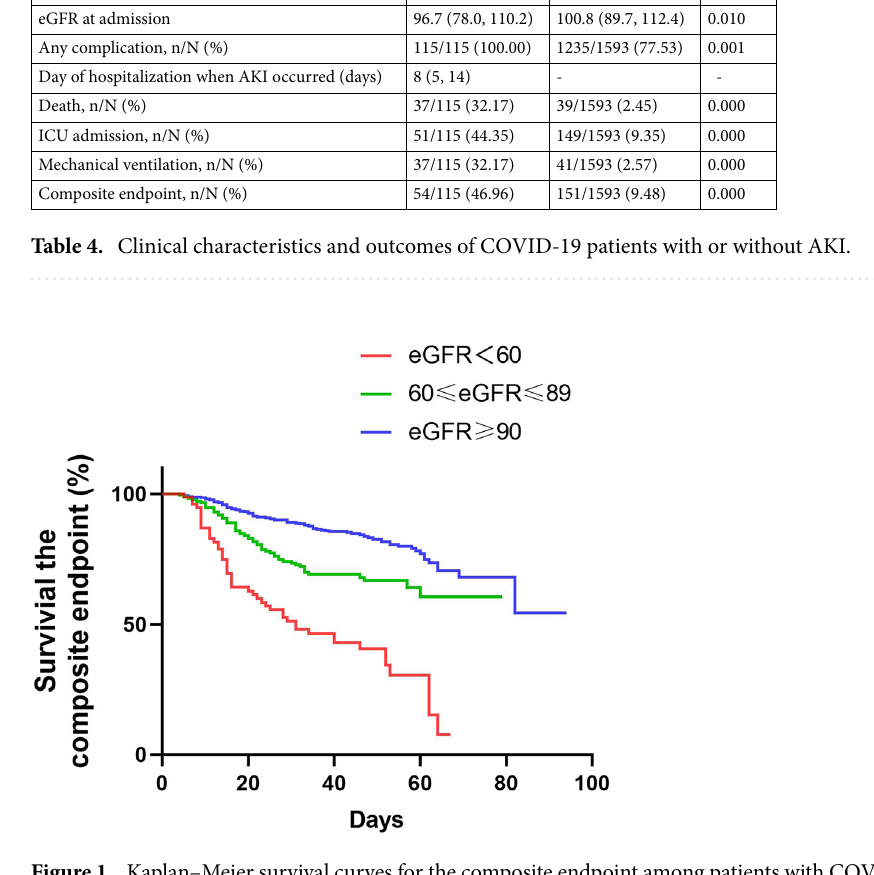
Figure 1. Kaplan–Meier survival curves for the composite endpoint among patients with COVID-19 stratified according to eGFR. COVID-19, coronavirus disease 2019; eGFR, estimated glomerular filtration